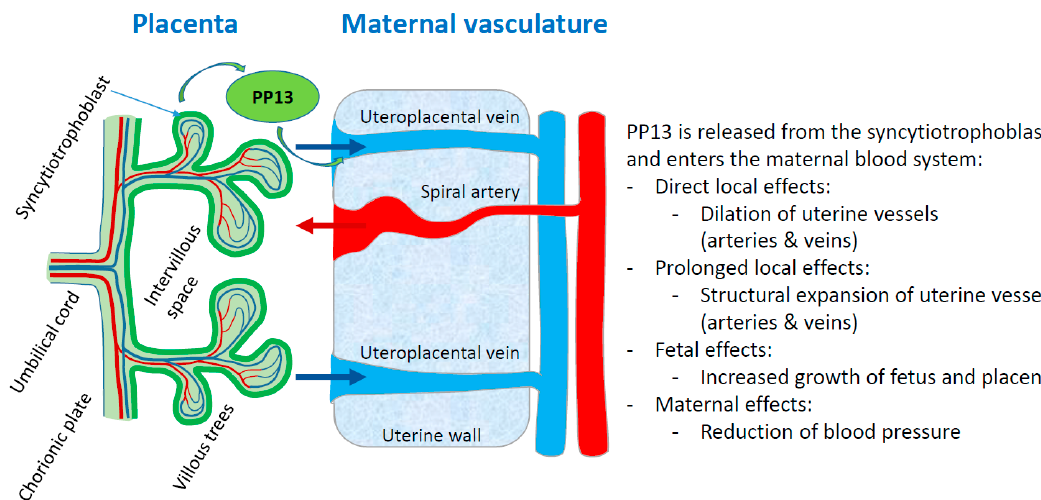
Figure 3. PP13 priming of maternal blood vessels. The scheme displays a comprehensive model of the PP13 effects on the vascular system of the mother. PP13 is released from the syncytiotrophoblast and enters the maternal blood system where it has different effects. The red arrow shows flow of maternal blood into the placenta via invaded spiral arteries, while the blue arrows indicate flow of maternal blood back from the placenta into the maternal vascular system via invaded uterine veins.